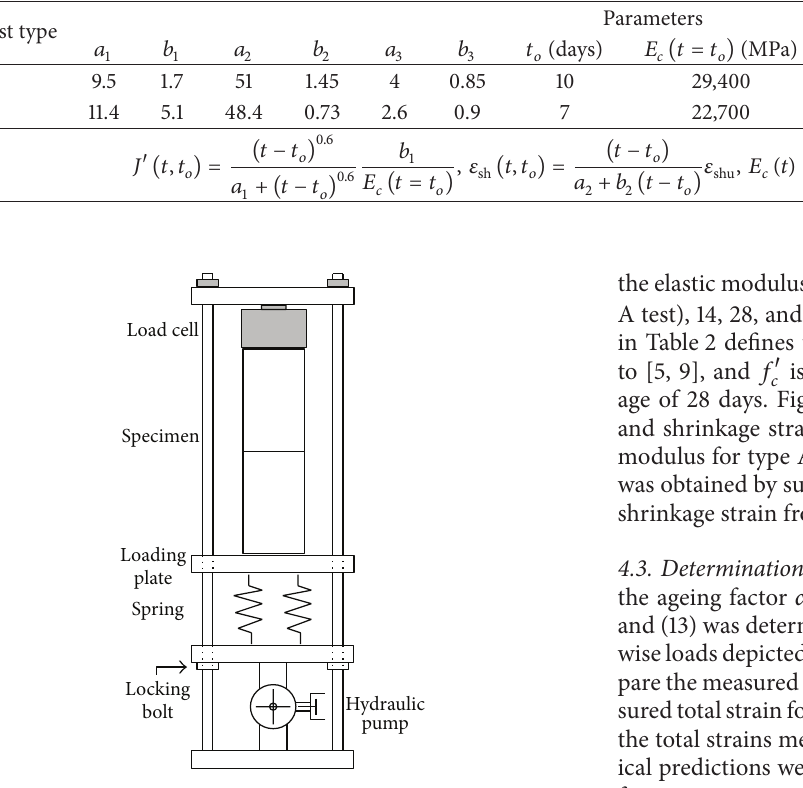
Figure 4: Schematic drawing of creep test